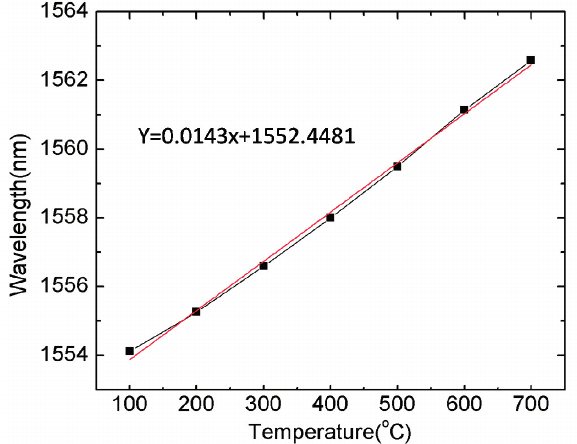
Figure 6. Wavelength shift of selected notch due to the temperature change. Reproduced with permission from [17]. Copyright 2014 Society of Photo-Optical Instrumentation